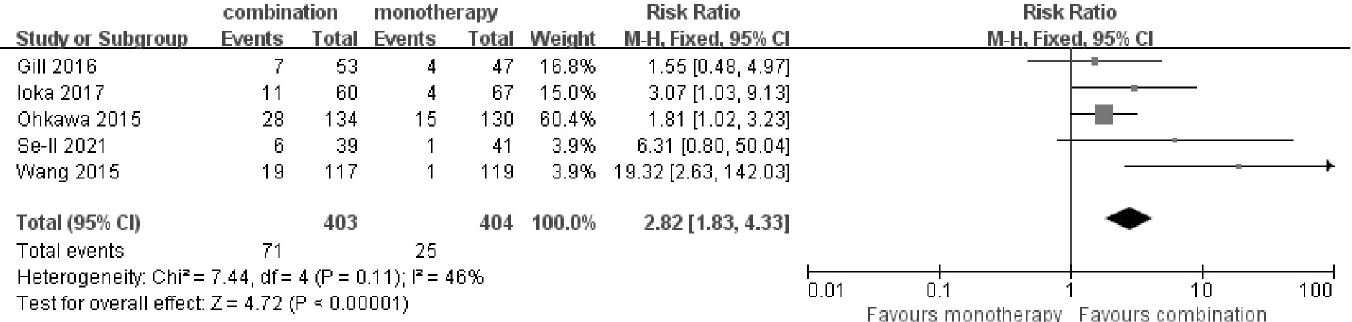
Fig 4. Comparison of ORR between fluoropyrimidine combination therapy and fluoropyrimidine monotherapy. CI: Confidence interval. M-H: Mantel-Haenszel. Diamonds represented the 95% confidence interval of overall effect.